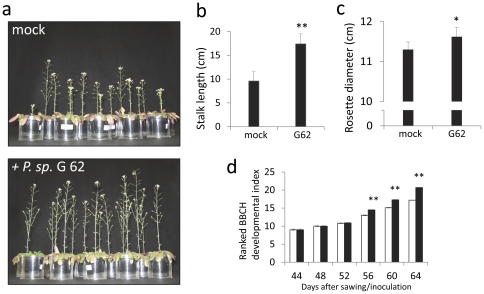
Growth effects of P. sp. G62 on Arabidopsis ecotype Gol-1 grown in sandy soil.a: Gol-1 with and without bacteria (mock) after a 68-day growth period. b: stalk length. c: rosette diameter. d: developmental index. Mean values ± SE, asterisks indicate p-values (*: p<0.05; **: p<0.01).